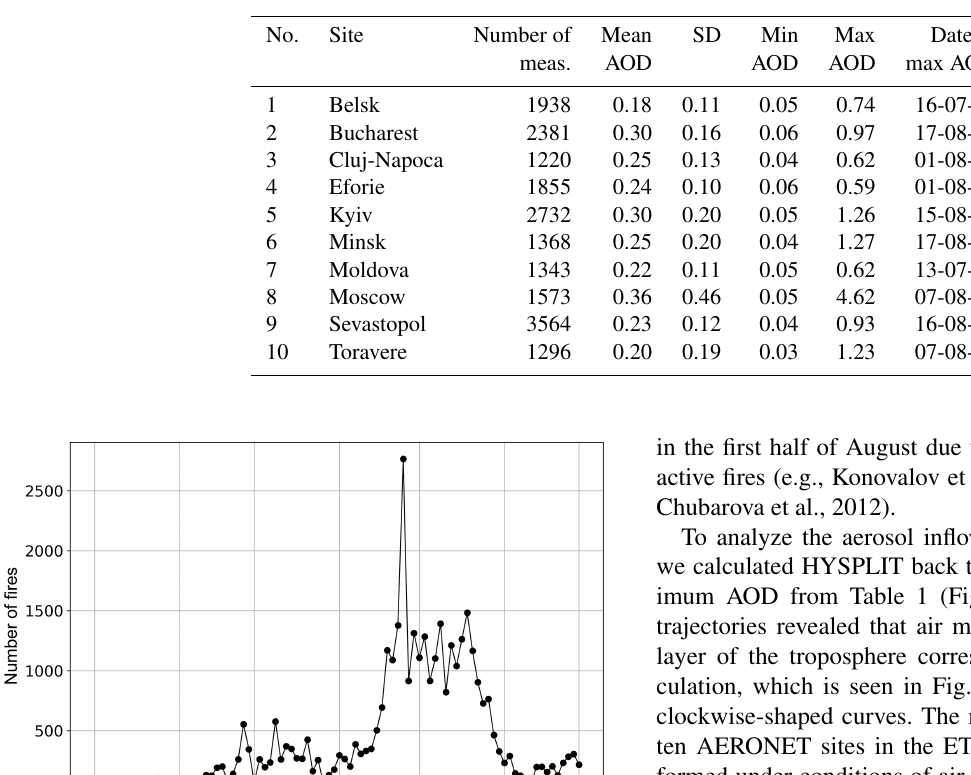
Table 1. Level of air pollution caused by aerosol (AOD 500nm) from 1 June to 31 August 2010 over the ETR and Eastern Europe according to AERONET.